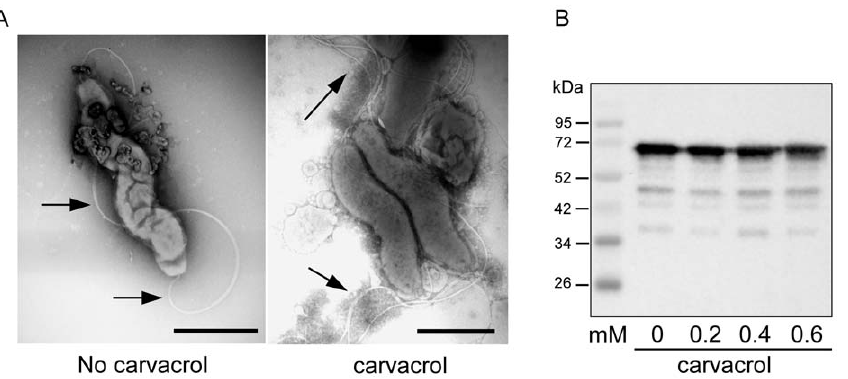
Figure 3. Effect of carvacrol on flagella formation. (A) Representative electronmicrographs of flagella-expression by C. jejuni strain 108 (arrows) grown in the absence (left panel) and presence (right panel) of 0.2 mM of carvacrol. Bar represents 1 m m. (B) Western blot of whole cell lysates of C. jejuni strain 108 grown at the indicated concentrations of carvacrol. The blot was probed with rabbit anti-flagella antiserum 313 and subsequently with goat-and-rabbit IgG-peroxidase and substrate. Molecular mass markers are indicated in kilodaltons (kDa).